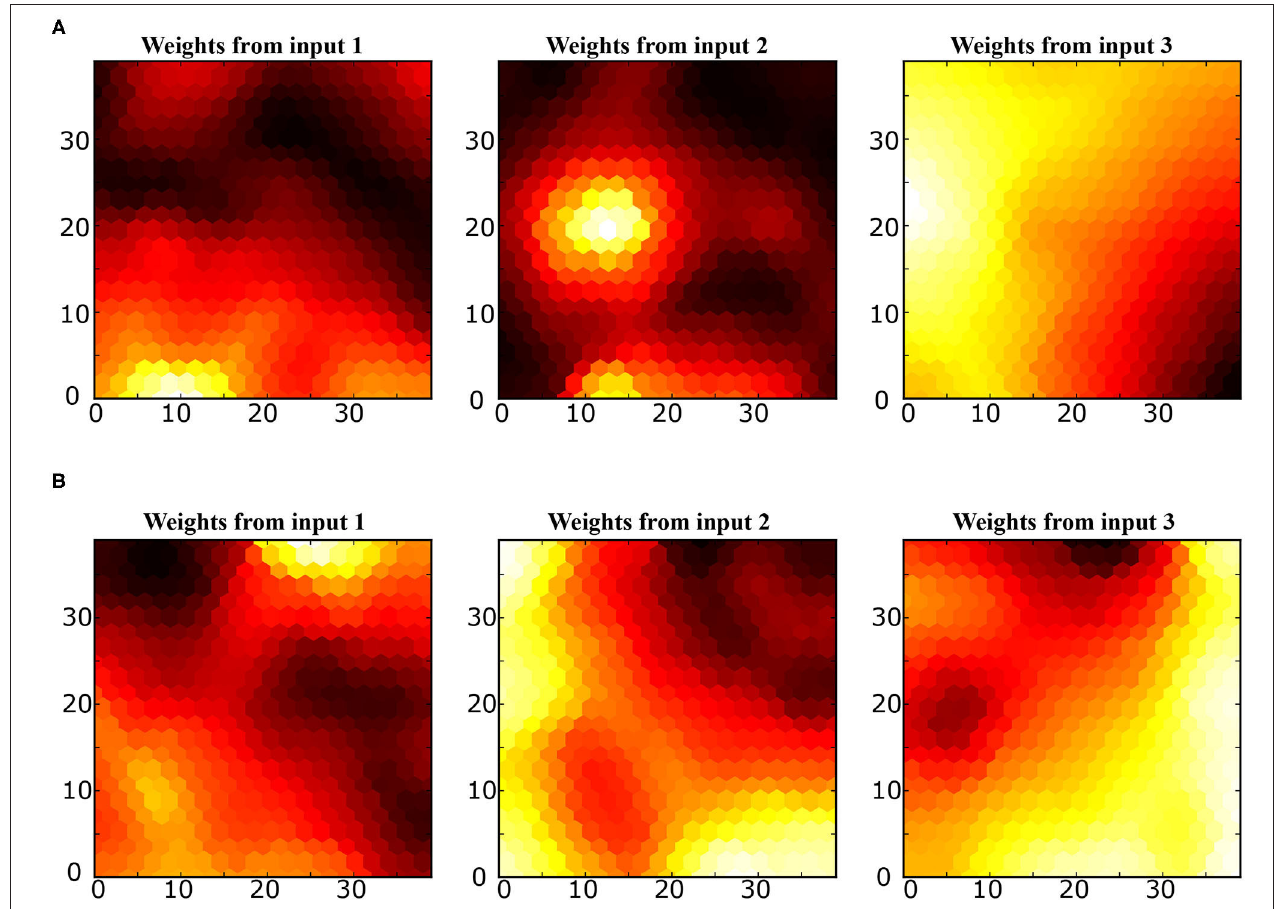
FIGURE 10 | Heatmaps of the varying density SOM depicting the relation between each input from the joint spaces of (A) the human arm and (B) robot agents.